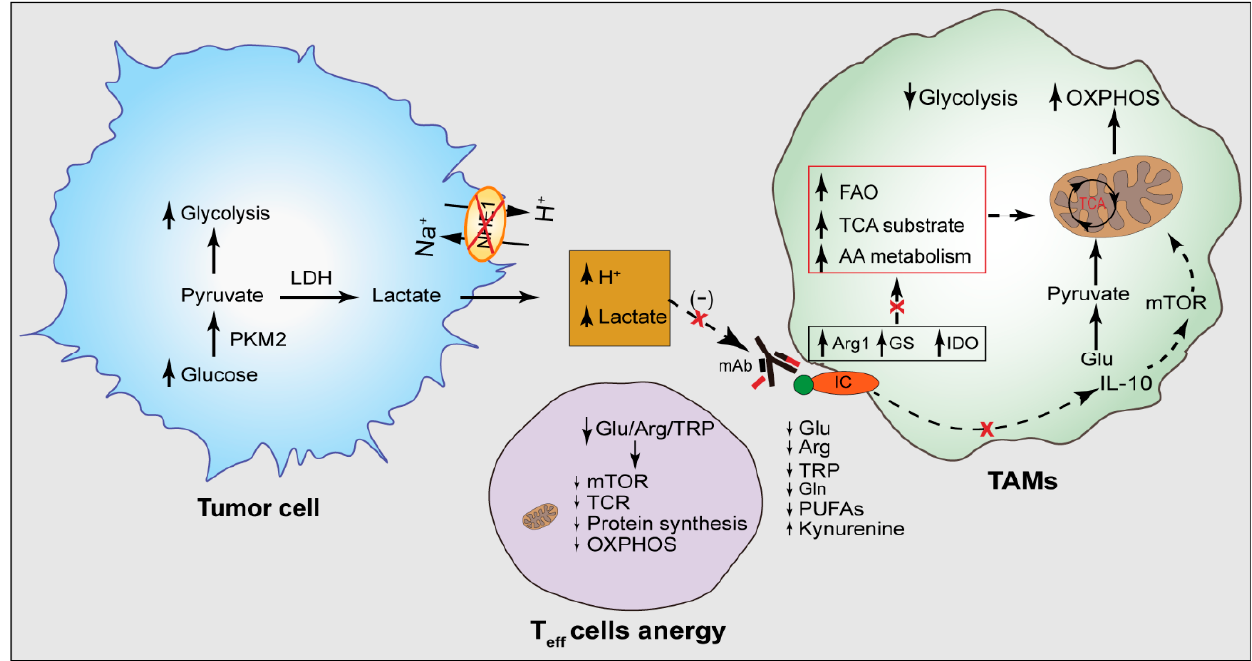
Figure 4. TAMs metabolism as a target for immunotherapy. Highly proliferative cancer cells use aerobic glycolysis and consume an elevated amount of glucose for bioenergetic and biosynthetic purposes releasing lactate and H + in the TME. In addition to affecting cellular signaling, acidic TME also affects therapeutic antibody function and integrity and may cause breakage of the antibodies. Immune checkpoint molecules cause elevation of IL-10 signaling which increases the TCA substrates and OXPHOS metabolism, and promotes TAM’s tumor promoting function. The elevated level of Agr1, GS, and IDO cause elevated flux of TCA cycle substrates via amino acid metabolism and FAO, resulting in increased OXPHOS metabolism, a hallmark of tumor-promoting TAMs. These lead to depletion of metabolites in the TME necessary for T cell’s effector function. Reducing TME acidity may increase the OXPHOS genes which elevates the OXPHOS metabolism, reduces glycolysis, and promotes TAM’s anti-tumor function. As the M1/M2 classification is overly simplified, the preference of glycolysis for M1 TAMs and OXPHOS for M2 TAMs are also simplified. Therefore, the increase of TAM’s OXPHOS, because of glucose metabolism to pyruvate and its progression to the TCA cycle, may increase the TAM’s anti-tumor function. Additionally, targeting Arg1, GS, and IDO, and reducing tumor acidity by blocking NHE1 activity may increase the key metabolites in the TME necessary for the T cells’ effector function. Glu, glucose; ARG1, arginase 1; IDO, indoleamine 2,3-dioxygenase 1; GS, glutamine synthase; AA, amino acids; FAO, fatty acid oxidation; PKM2, pyruvate kinase M2; LDH, lactate dehydrogenase; TCR, T cell receptor; mTOR, mammalian target of rapamycin; IC, immune checkpoint; mAb, monoclonal antibody. 4.4. Effect of Tumor Acidity on the Activity of Therapeutic Antibodies Due to the elevated aerobic glycolysis in tumor cells, lactate and H + accumulate in the TME making an acidic TME that directly blunts T cells’ anti-tumoral response and therapeutic antibodies’ activity [97,163,164]. A low pH induces the TAMs’ transformation to immune-suppressive M2 macrophages, which blocks the anti-tumoral T cell response [97]. As T cell activity is required for immune-checkpoint antibodies’ efficacy, the depleted anti-tumoral T cell response is one of the underlying factors that interfere with immunotherapy efficacy [97,163]. It has been shown that the administration of alkalinizing agents to colorectal cancer patients increased the pH of the TME, resulting in the reversal of the lessened anti-tumoral T cell response stemming from a low pH [165]. The administration of alkalinizing agents significantly increased the overall response to the therapeutic antibodies along with the resurgence of an anti-tumoral T cell response [165]. The acidic pH of the TME negatively affected the therapeutic antibodies by the breakdown of antibodies and damaging their binding capacities to the cell-surface targets [97]. Additionally, Pilon-Thomas et al. showed that when mice bearing melanoma were